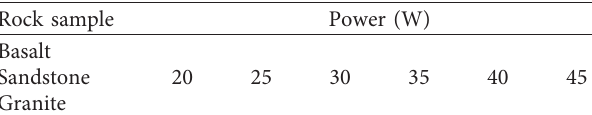
Table 3: Experimental parameters of laser power (irradiation time